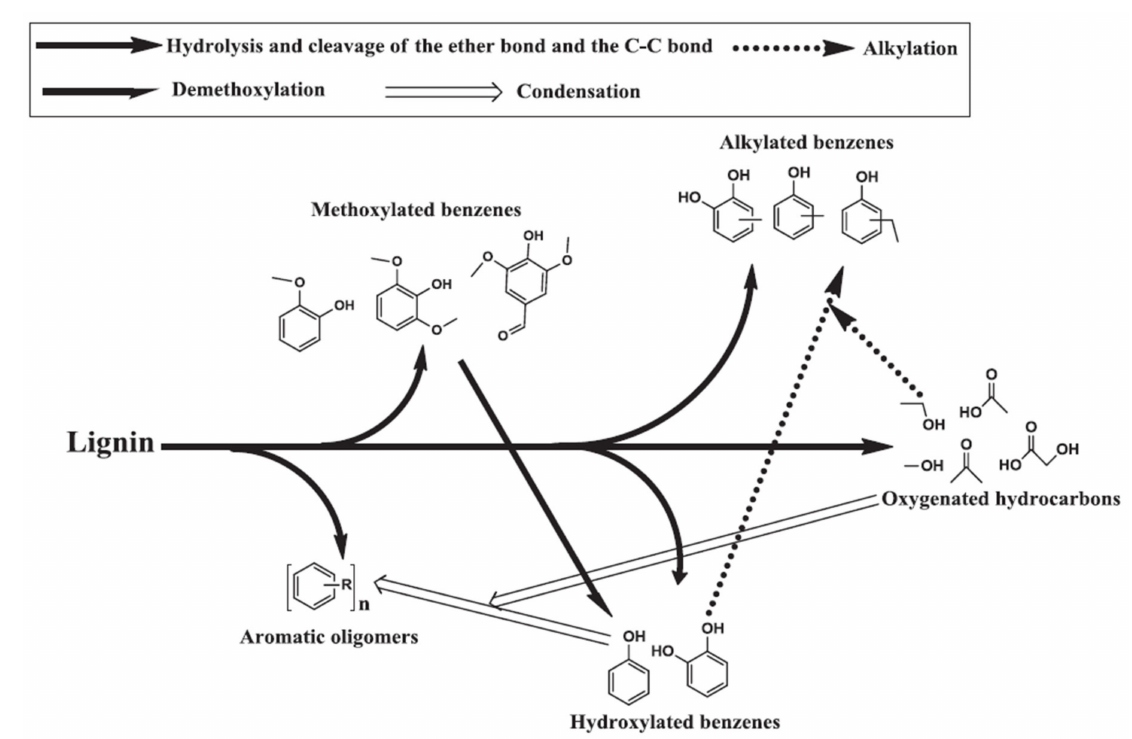
Figure 4. Proposed pathway for hydrothermal lignin decomposition [55], copyright Elsevier